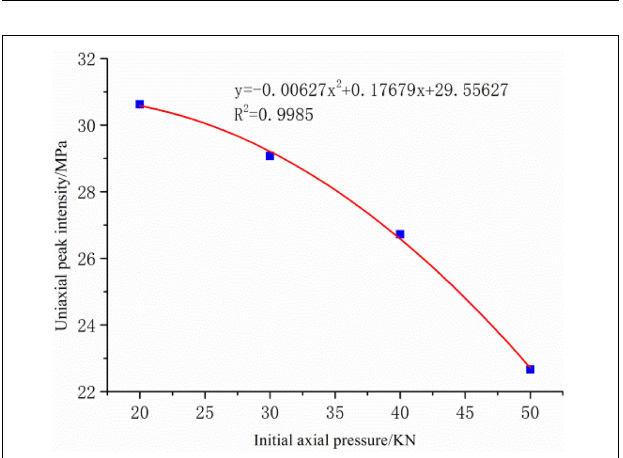
FIGURE 11 | Uniaxial compressive stress–strain curves.